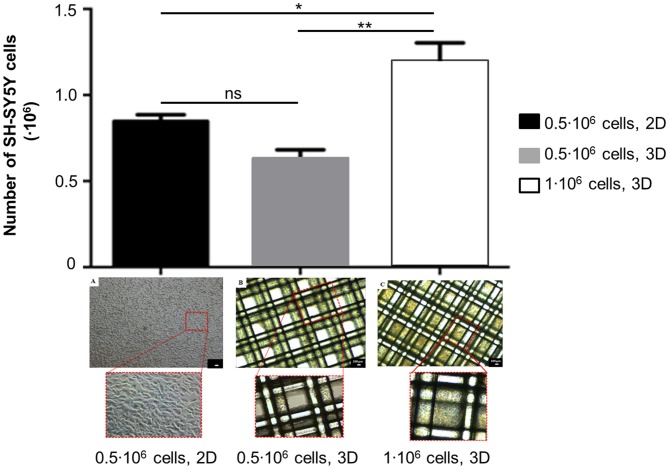
Assessment of cell number and morphology in 3D scaffolds seeded with 0.5·106 or 1·106 SH-SY5Y cells (mean ± SD, n = 3). The seeding of 0.5·106 cells in 2D was considered as a reference. Statistical analysis was performed with one-way ANOVA followed by Tukey’s multiple comparisons test. Ns, p-value > 0.05; *p-value < 0.05; **p-value < 0.01. Optical micrographs of: (A) 0.5·106 cells/well, 2D; (B) 0.5·106 cells/scaffold; (C) 1·106 cells/scaffold. Magnification = 4×, scale bar = 100 μm.